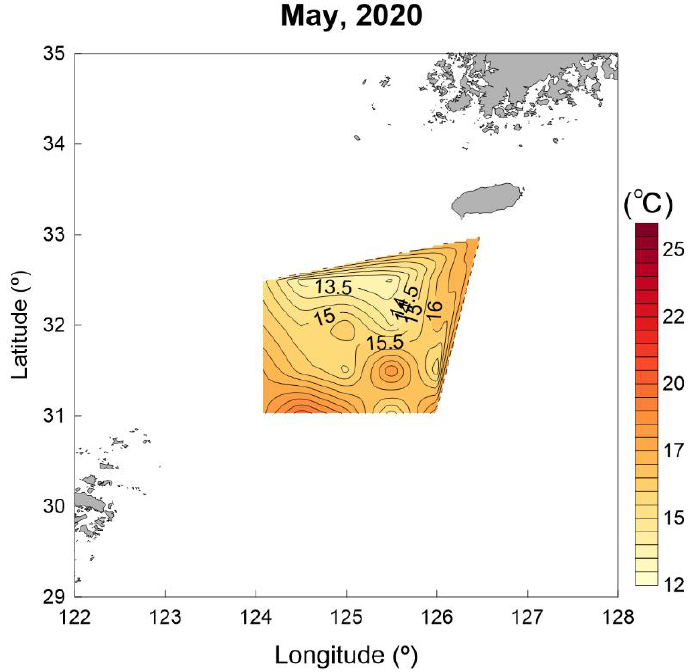
Figure 7. Distribution of temperature in the major swimming layers in the East China Sea.